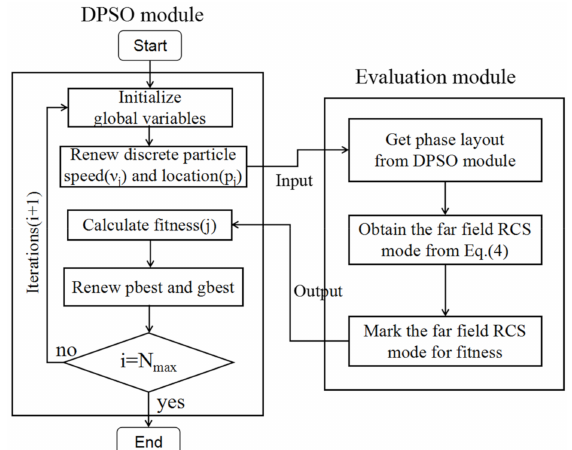
Figure 5. The flowchart of discrete particle swarm algorithm (DPSO) module and Evaluation